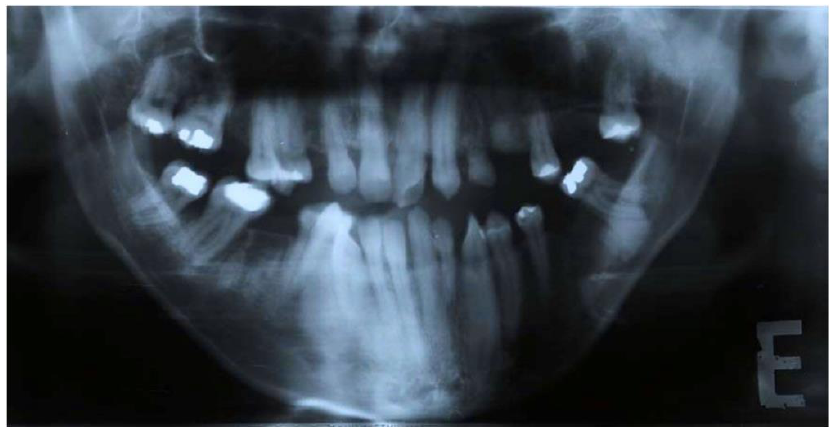
Figure 3. Pre-treatment panoramic radiograph of patient showing several missing teeth, radiculomegaly, and dilaceration of roots.